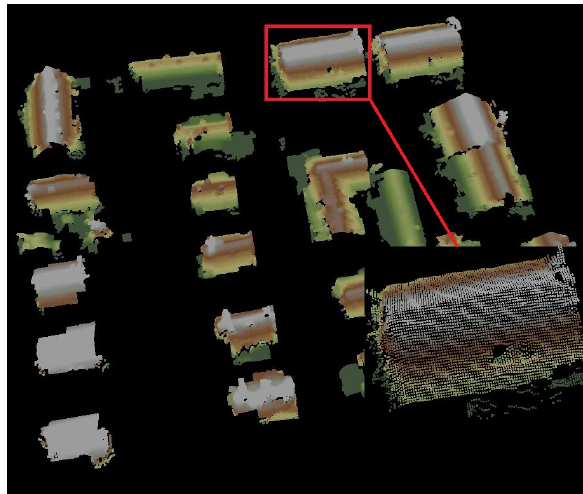
Figure 2: Points on the building roof due to the classifcation of SCOP ++ in a 3D view.